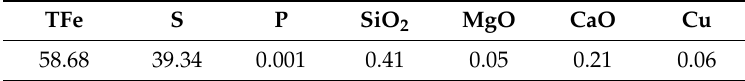
Table 1. Chemical compositions of the pyrrhotite single mineral (mass fraction/%).